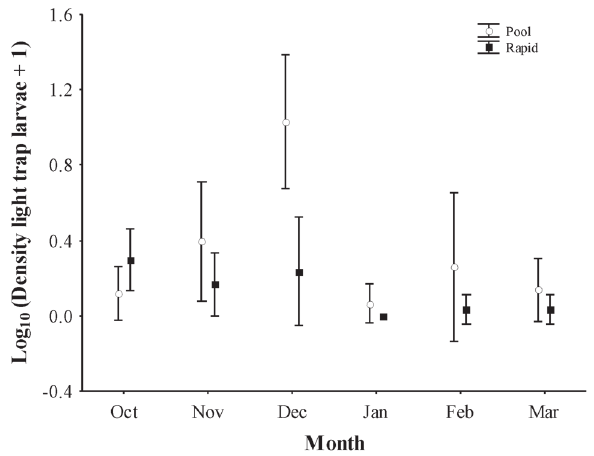
Fig. 8. Average density ± standard error of the larvae cap- tured in the Peixe River with light traps in different environ- ments and months from October 2011 to March